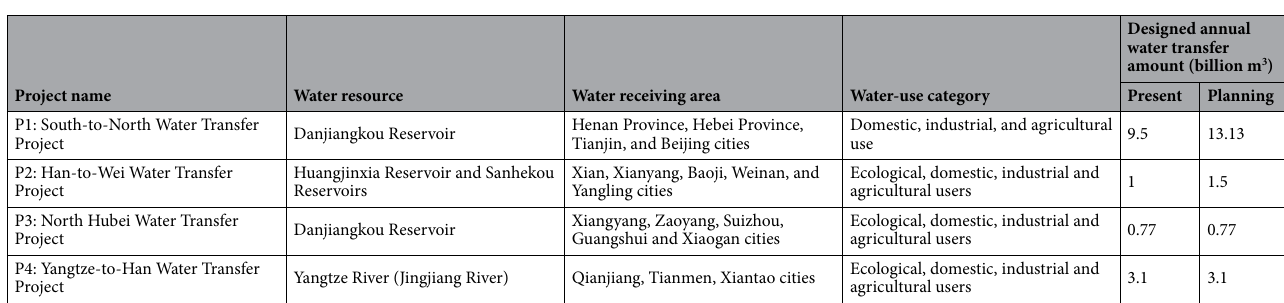
Table 1. Description of inter-basin and intra-basin water transfer